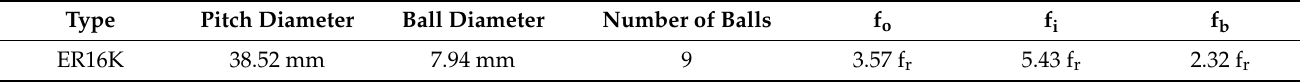
Table 1. Parameters of the bearing.